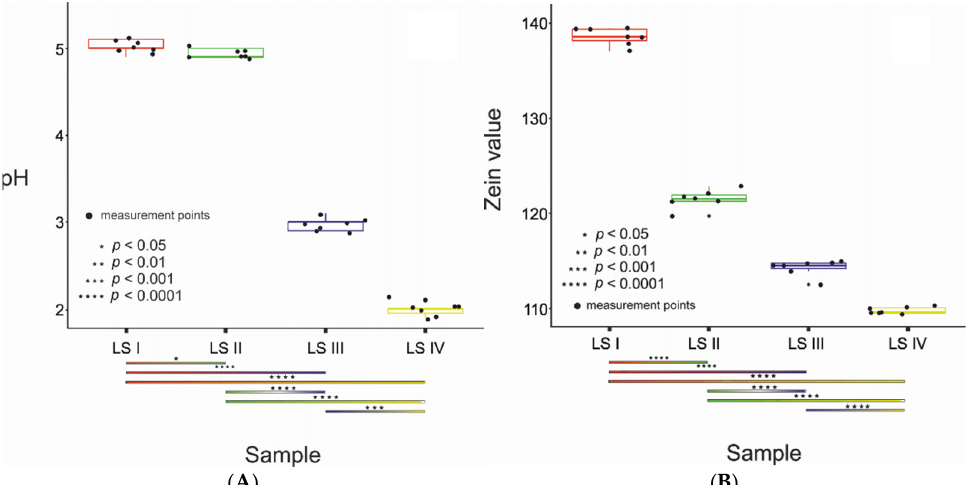
Figure 1. Bovine albumin assay ( A ) and zein assay ( B ) of tested soaps (LS I—base; in following soaps addition of 4% ( w/w ) surfactants: LS II—cocamidopropyl betaine; LS III—addition of cocamidopropyl hydroxysultaine; LS IV—addition of evening primroseamidopropyl sulfobetaine). Results were calculated from the formula: (end pH—initial pH)/initial pH, and presented as median with quartiles (25% and 75%), n = 7, three independent experiments.